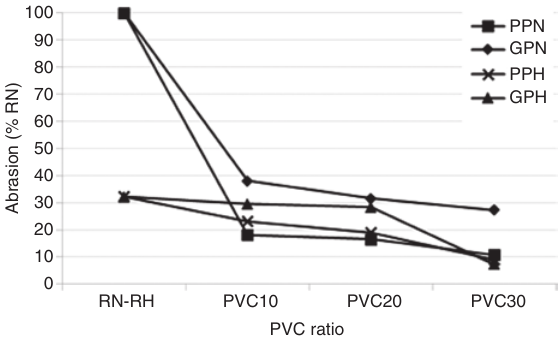
Figure 14 Capillary water absorption of polyvinyl chloride granule containing normal strength concretes.